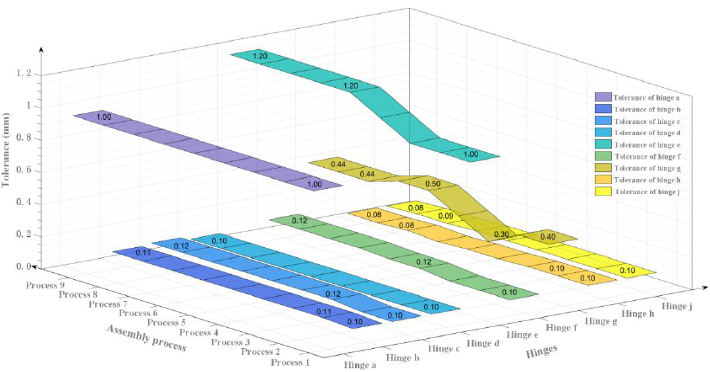
Figure 17. Dynamic allocation of hinge minimum tolerance.